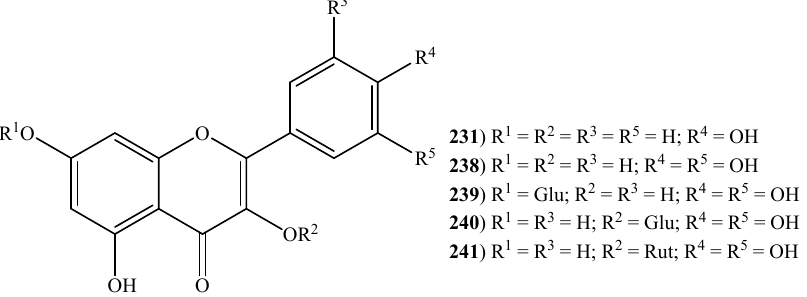
Figure 6. Some flavones identified in halophytic grasses (Glu = D -glucose) (see Table S1).